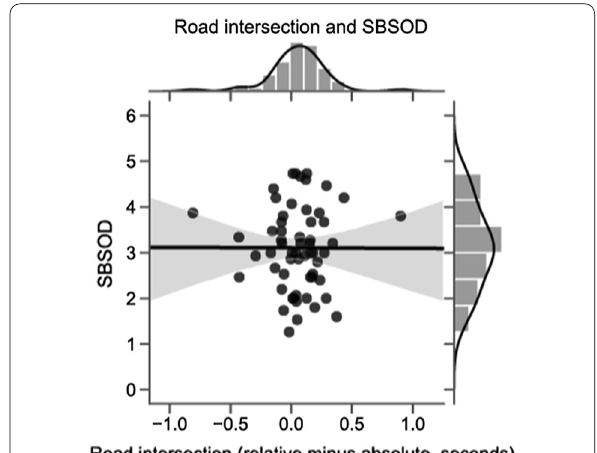
Fig. 3 Correlation between navigation ability and reference frame preference on the road intersection task. Self-reported navigation ability (as measured by the Santa Barbara Sense of Direction [SBSOD] scale) showed no relationship to reference frame preference on the road intersection task. Better navigators did not respond more quickly to one reference frame type over another